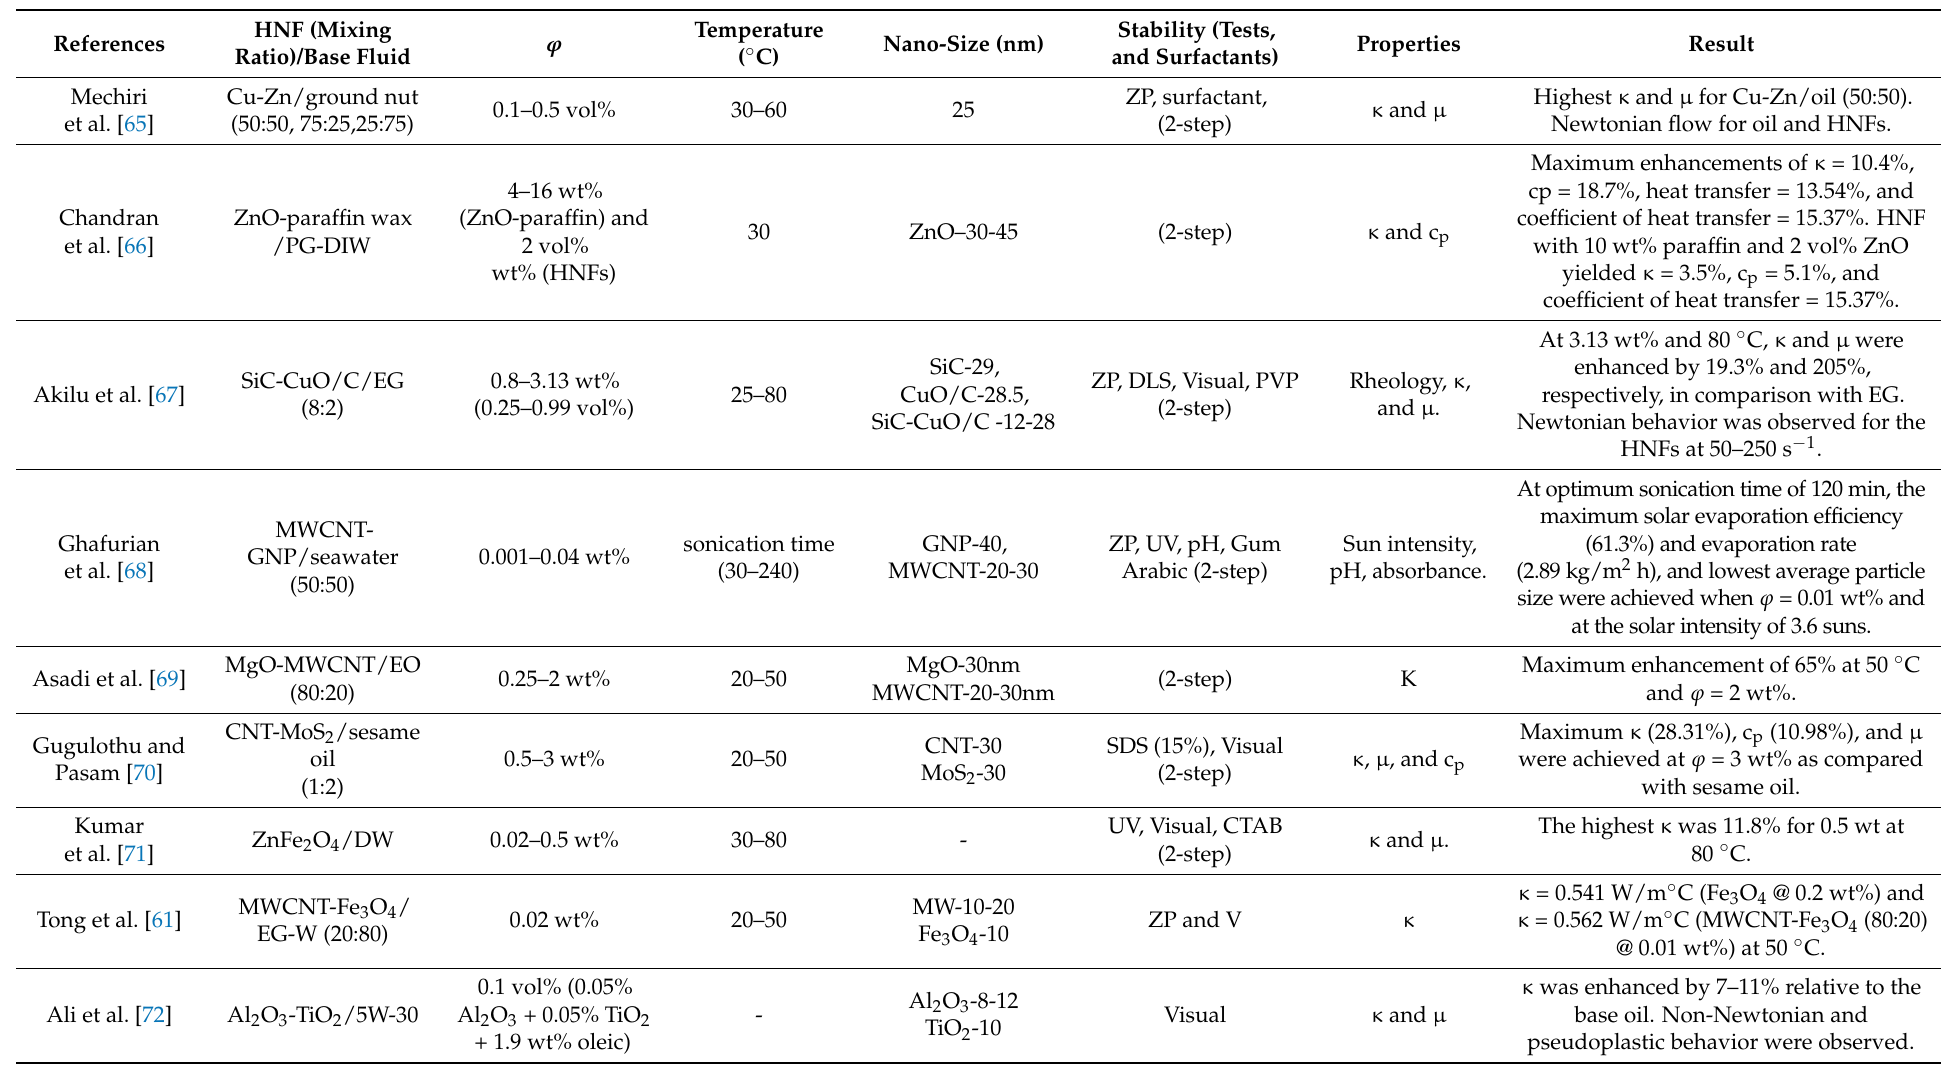
Table 1. Different HNPs, base fluids, surfactants, stability tests, process methods, and thermo-optical properties related to HNFs use in solar energy